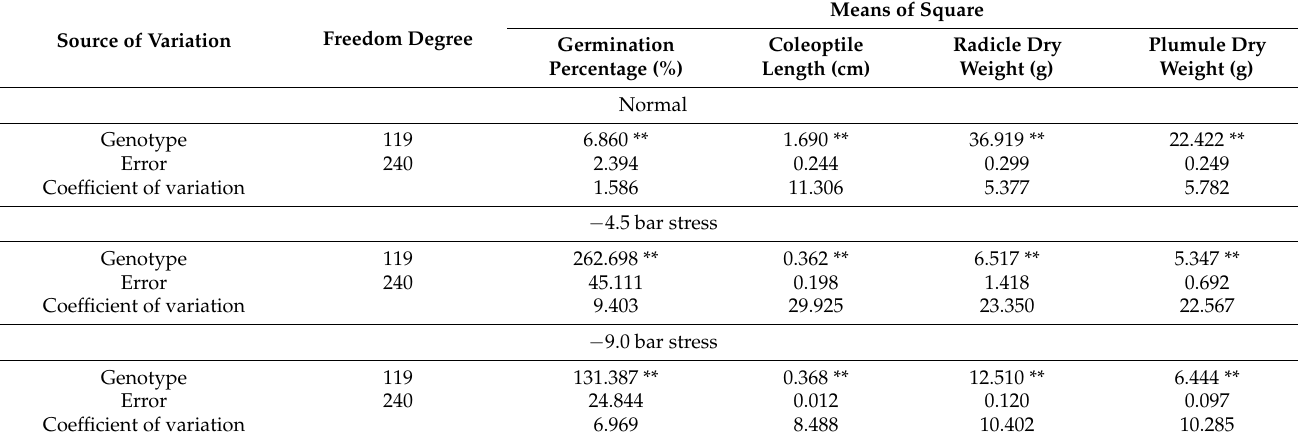
Table 1. Analysis of variance of studied traits at germination stage under normal, − 4.5 bar, and − 9.0 bar conditions.